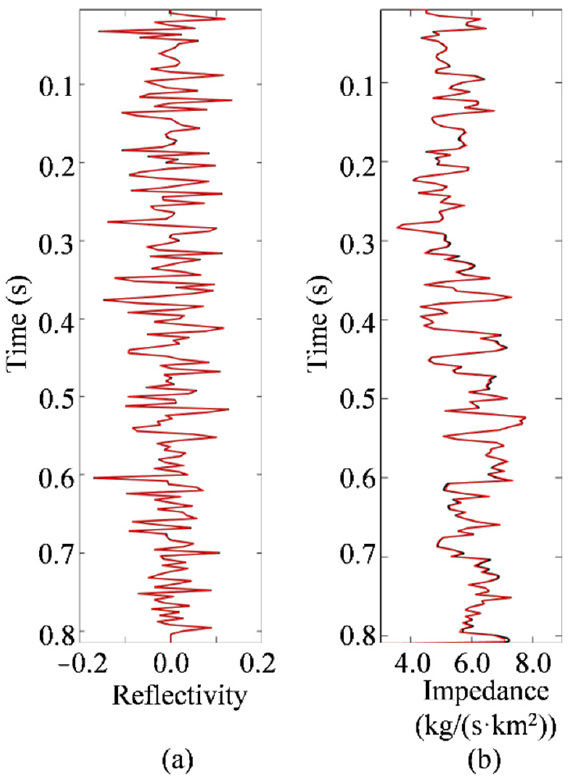
Figure 5. The inverted reflectivity series and impedances from ENRI performed on the noise-free synthetic trace. ( a ) Reflectivity series; ( b ) impedance.